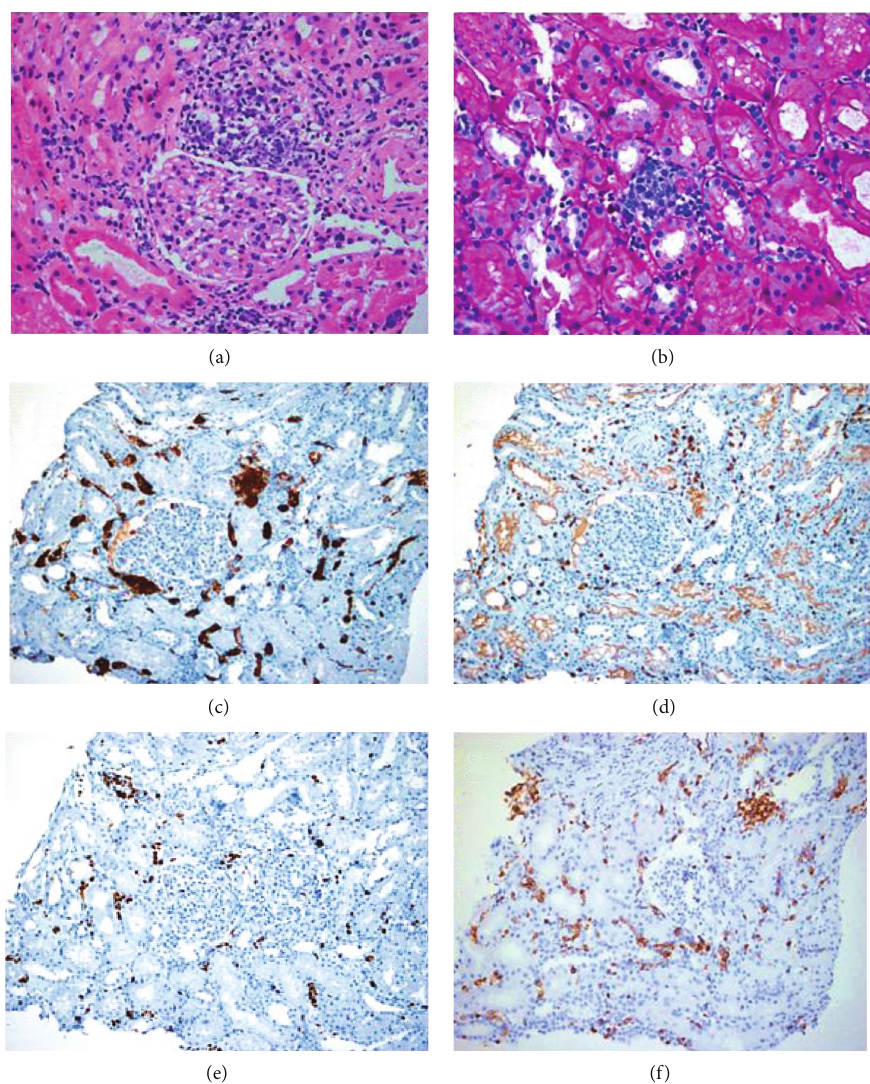
Figure 2: Kidney biopsy. (a) Hematoxylin-eosin staining of the kidney showing the presence of large atypical lymphocytes with an irregular nucleus in the glomerulus and tubules. (b) PAS staining of the kidney showing the presence of lymphocytes in the peritubular capillaries. (c) CD20 staining showing the presence of atypical B-lymphocytes. (d) CD3 staining. (e) KI67 staining showing a proliferation (80%). (f) CD5 staining was positive in this patient and associated with a poor prognosis in